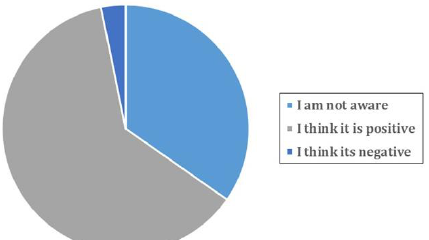
Fig. 8. Opinion with regard to land-user initiatives (Source: own